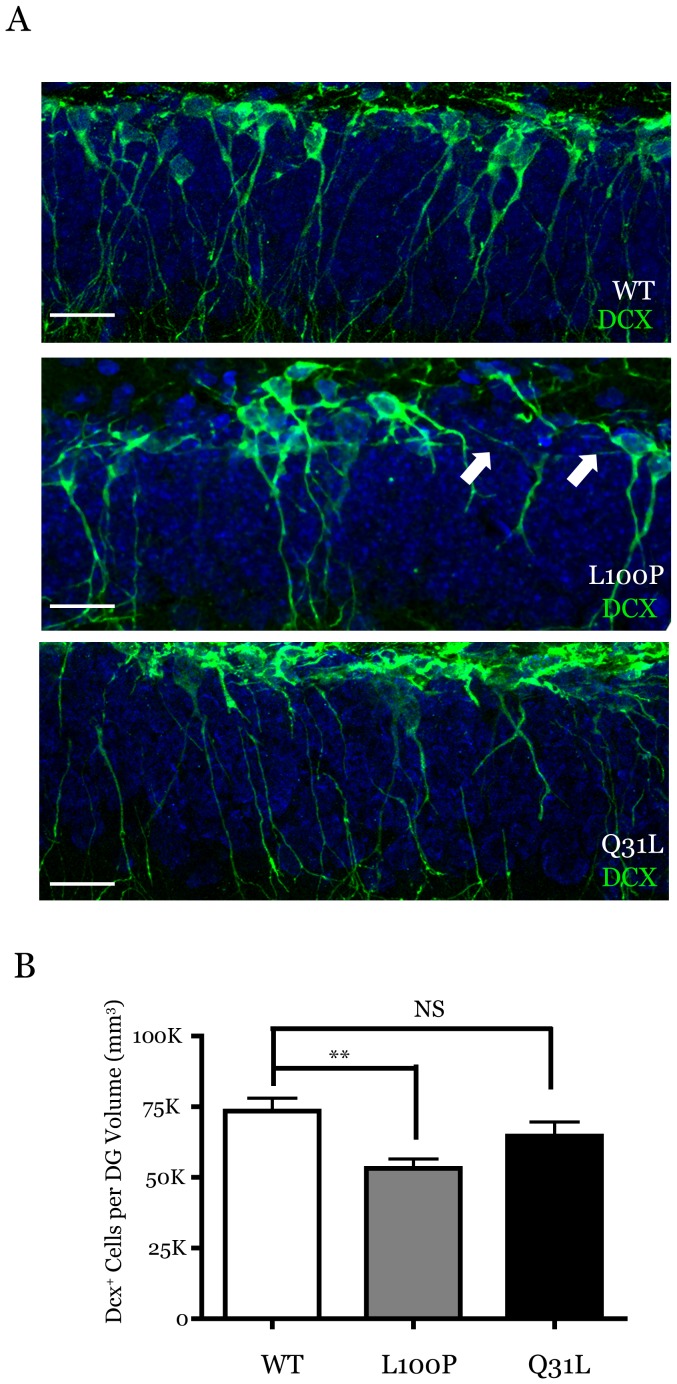
Loss of immature neurons in Disc1
100P/100P mice.(A) Immunolabelling of immature neurons residing in the subgranular zone with an antibody raised against doublecortin (DCX) identify frequent gaps (arrows) in DCX staining solely in Disc1
100P/100P mice that reflect a significant loss (B) of DCX+ cell bodies compared to wild-type controls (post-hoc Bonferroni p<0.05; n = 8 wild type, n = 5 Disc1
31L/31L. n = 6 Disc1
100P/100P). Data presented as mean ± SEM. Scale Bar (A) 100 µm (B) 25 µm